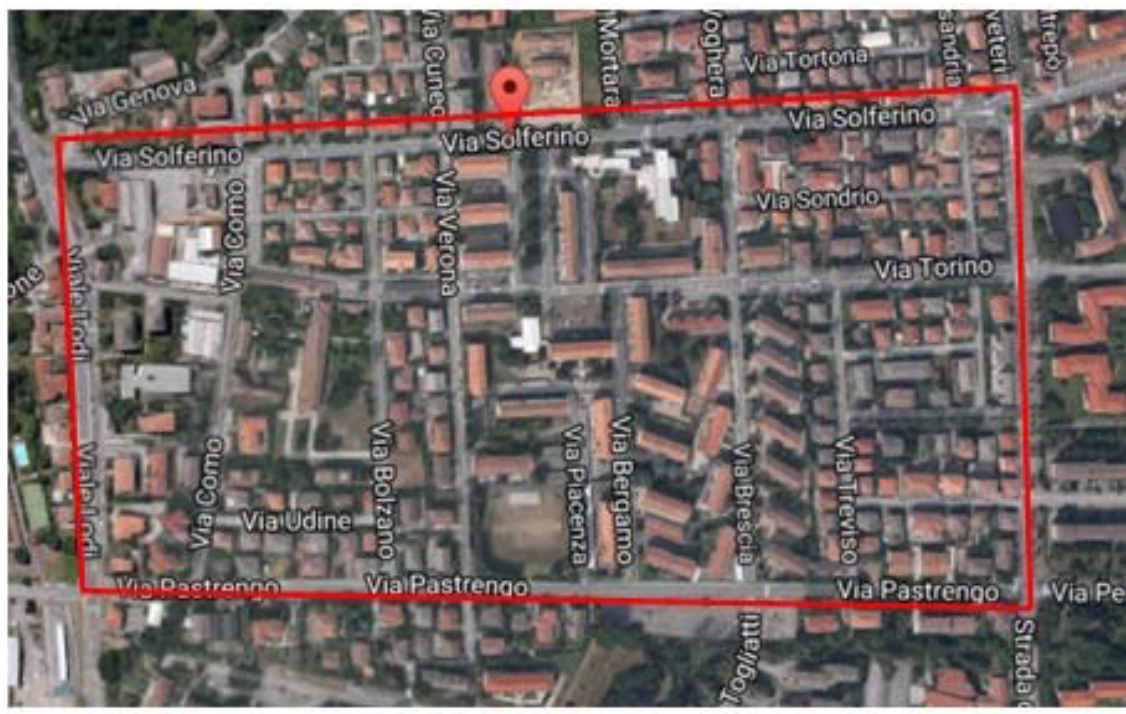
Figure 4: The urban area of Pavia